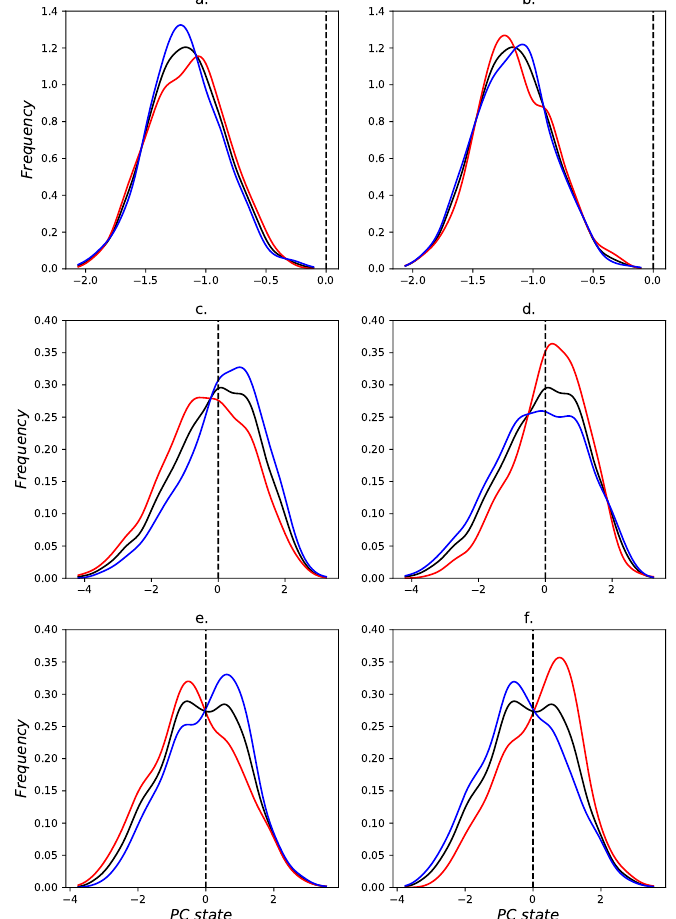
Figure 7. Winter distributions of the 3 first Principal Components corresponding to Figure 3. In each panel 3 distributions are plotted, the distribution of all winters (in black); the distribution of risk higher than normal (in red); the distribution of risk lower than normal (in blue). ( a ) distributions of the seasonal pattern PC corresponding to a risk of high consumption and low production ( R c + p − ); ( b ) distributions of the seasonal pattern PC corresponding to a risk of a risk of low consumption and high production higher than normal ( R c − p + ). ( c , d ) same as ( a , b ) for the NAO pattern. ( e , f ) same as ( a , b ) for the SCA